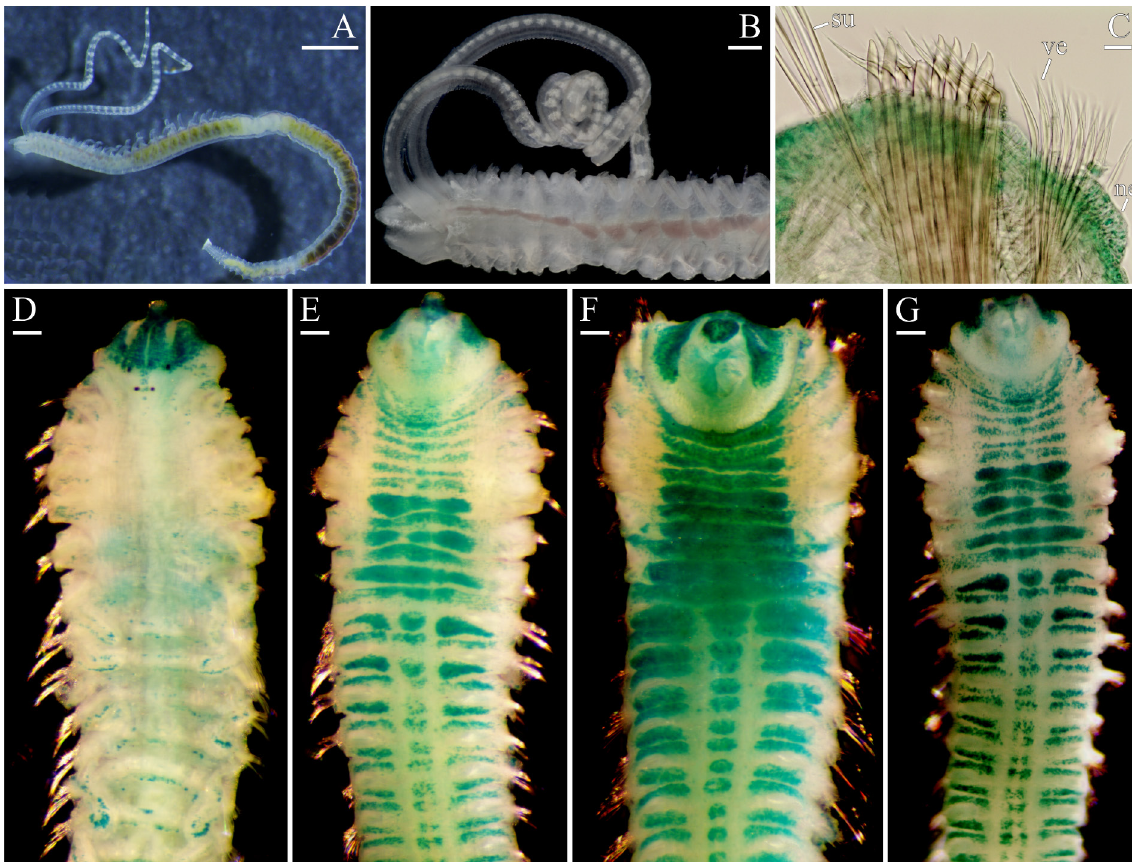
Fig. 10. Adult morphology of Pseudopolydora arabica Radashevsky & Al-Kandari, 2020 live individuals (A–B) and formalin-fixed specimens stained with MG (C–G). A–C . MIMB 39111. D–G . MIMB 40911. A . Left lateral general view, in reflected light, showing yellowish-white chromatophores on palps. B . Anterior end, dorsal view, in reflected light. C . Parapodia of chaetiger 5. D . Anterior end, dorsal view. E–F . Anterior ends, ventral view. Abbreviations: ne = neuropodial postchaetal lamella; su = dorsal superior capillary chaetae; ve = ventral capillary chaetae. Scale bars: A = 1 mm; B = 200 µm; C = 20 µm; D–G = 100